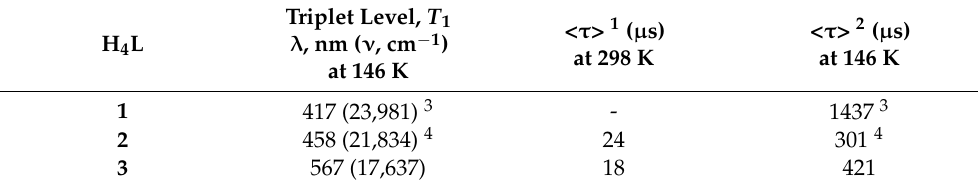
Table 3. Energies of lowest triplet states ( T 1 ) of ligands H 4 L( 1 – 3) in the 2:2 complexes, average lifetimes of the Yb 3+ -centered luminescence (< τ > 1 ) and ligand-centered phosphorescence of the Gd 3+ complexes (< τ > 2 ).